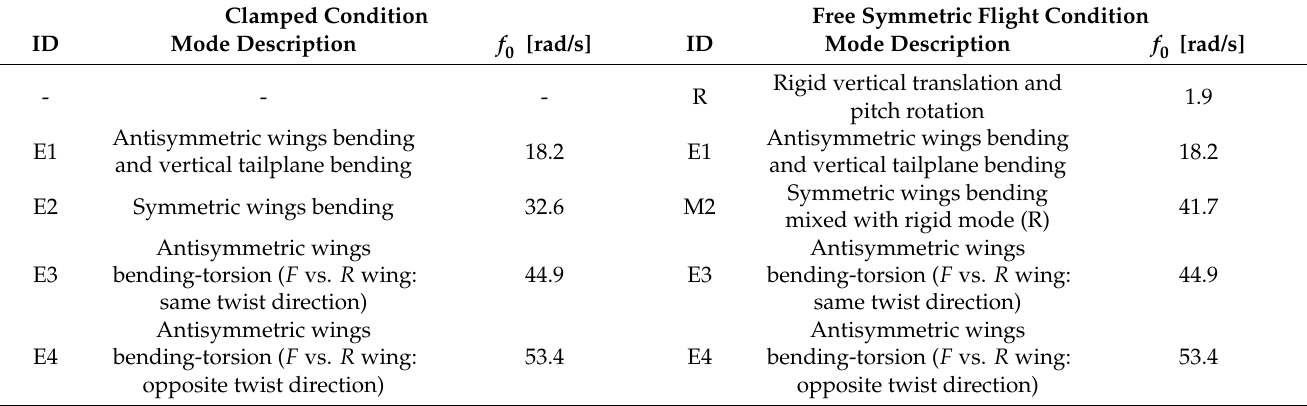
Figure 17. Flutter analysis results for the box-wing architecture under clamped ( left ) and free sym- metric flight ( right ) conditions. Figure 17-left refers to the clamped case and shows that the damping of mode E3 becomes positive for a flight speed between 50 m/s and 55 m/s. Looking at the frequency- speed chart, it is possible to observe that this flutter condition is probably related to the interaction of E3 with E1, rather than E4. In fact, in terms of frequencies E3 and E4 are close at each flight speed, whereas E1 assumes the same frequency values in the speed